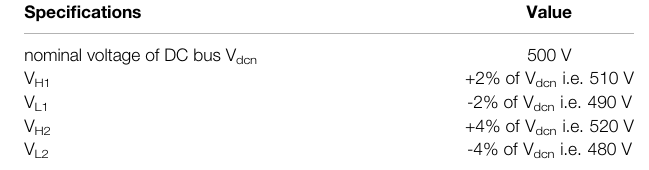
TABLE 3 | Speci fi cations of the